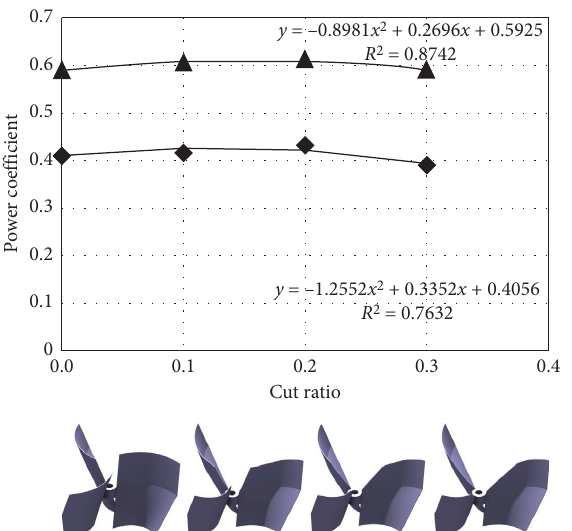
Figure 16: Set 6 data points (left to right—runners R15, R17, R18, and R19).